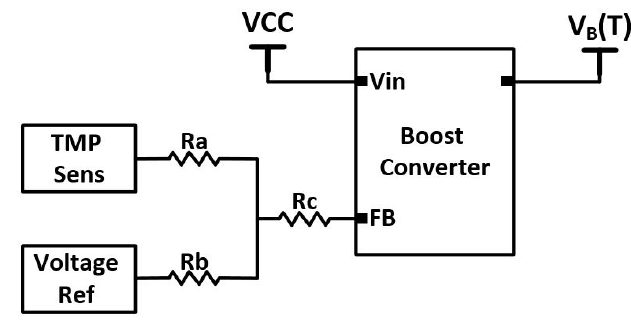
Fig. 6. Temperature dependent bias voltage